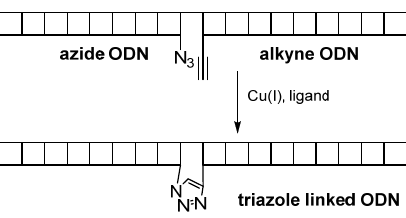
Scheme 3. Schematic template-mediated click-ligation of two oligonucleotides.